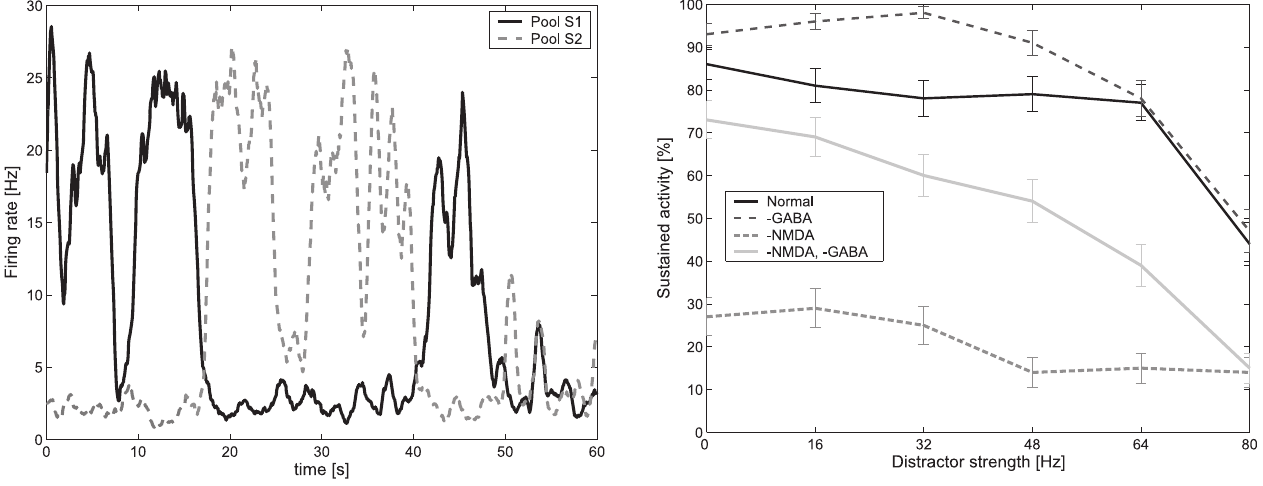
Figure 4. Wandering between Attractor States We simulated a single long trial (60 s) in the spontaneous test condition for the synaptic modulation ( (cid:2) NMDA, (cid:2) GABA). The two curves show the activity of the two selective pools over time smoothed with a 1-s sliding averaging window. The activity moves noisily between the attractor for the spontaneous state and the two persistent states S1 and S2 by virtue of statistical fluctuations caused by the randomness of the spiking activity.